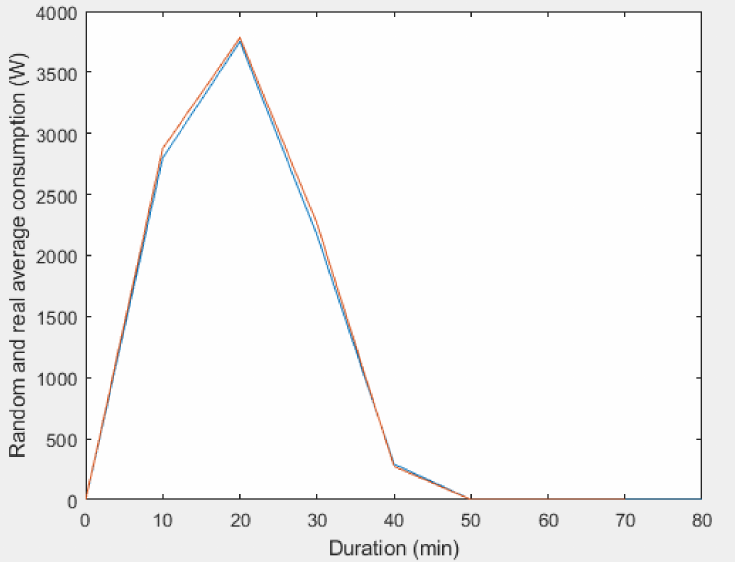
Figure 13. Random (blue) and real (orange) average consumption of the dryer whose duration is 40 min during working